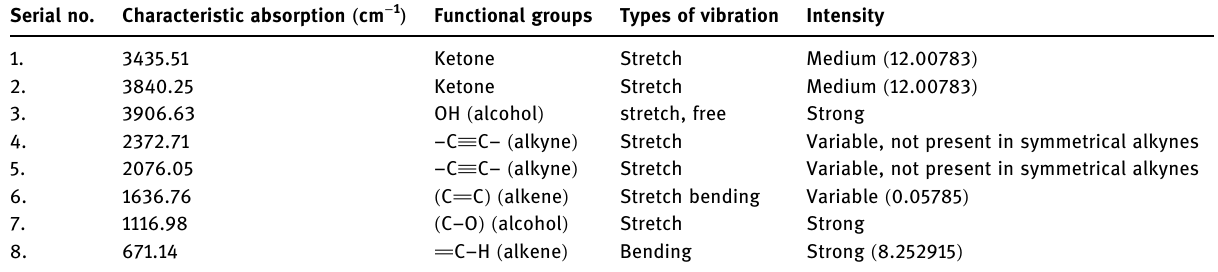
Table 3: FTIR of ethanolic extract of D. viscosa Serial